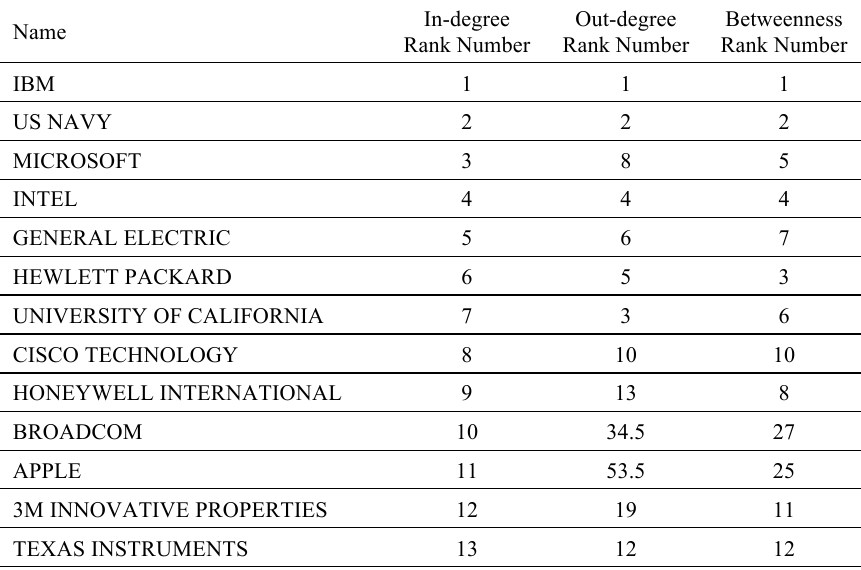
Table 2. The Most Central Nodes in the Network Sorted by In-degree Ranks The Most Central Nodes In The Network Sorted By In-degree Ranks